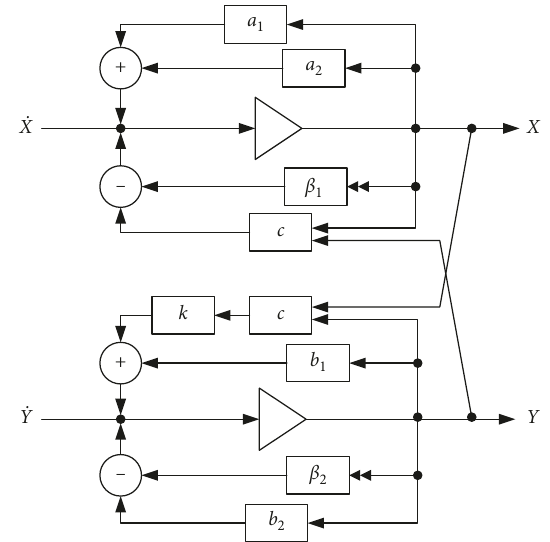
Figure 1: The dynamic relationship of employers and employees in a long-term cooperation (the right triangle “ ⊳ ” represents the integral